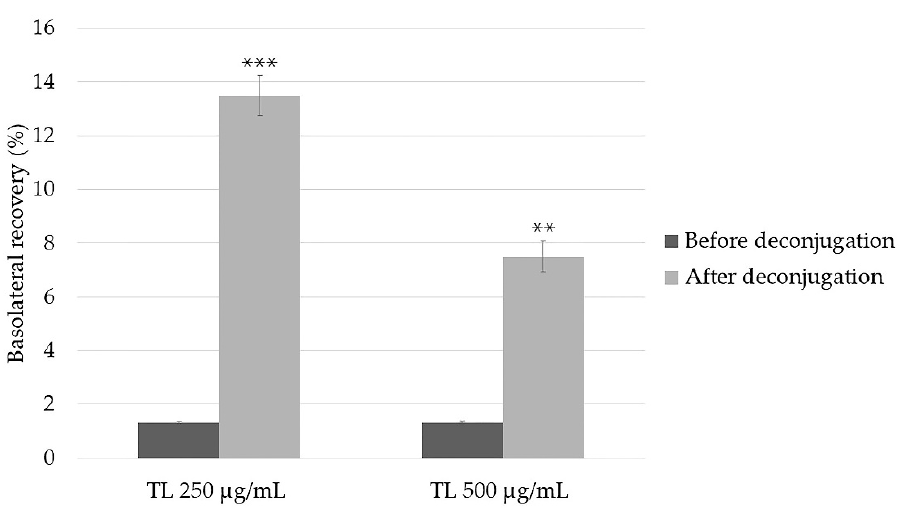
Table 2. The P app of RA in TL extracts and pure RA before and after deconjugation.